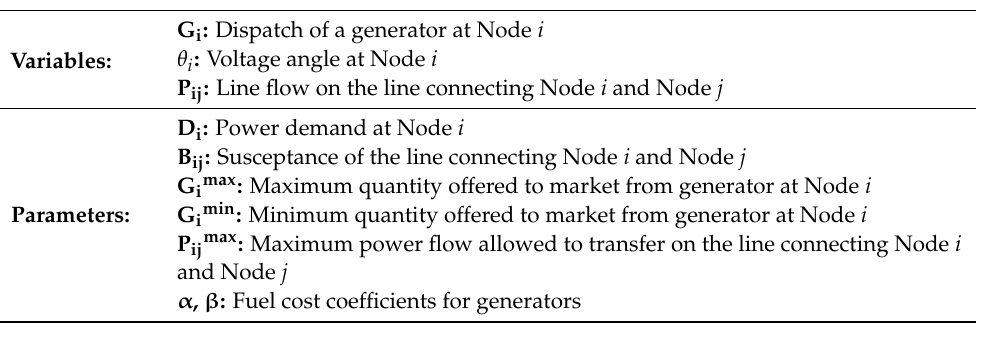
MODEL 1. DC OPTIMAL POWER